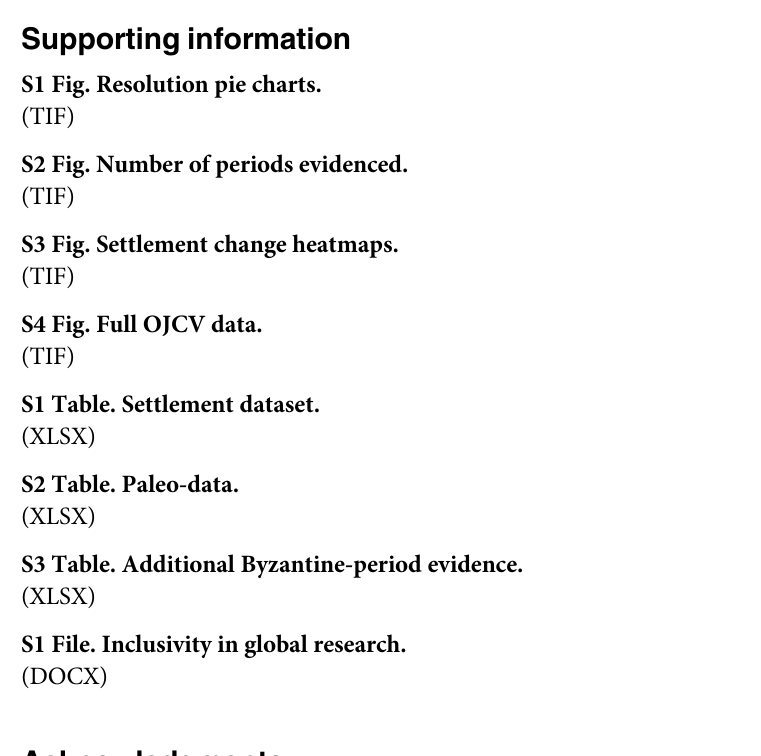
S1 Fig. Resolution pie charts. S2 Fig. Number of periods evidenced. S3 Fig. Settlement change heatmaps. S4 Fig. Full OJCV data. S1 Table. Settlement dataset. S2 Table. Paleo-data. S3 Table. Additional Byzantine-period